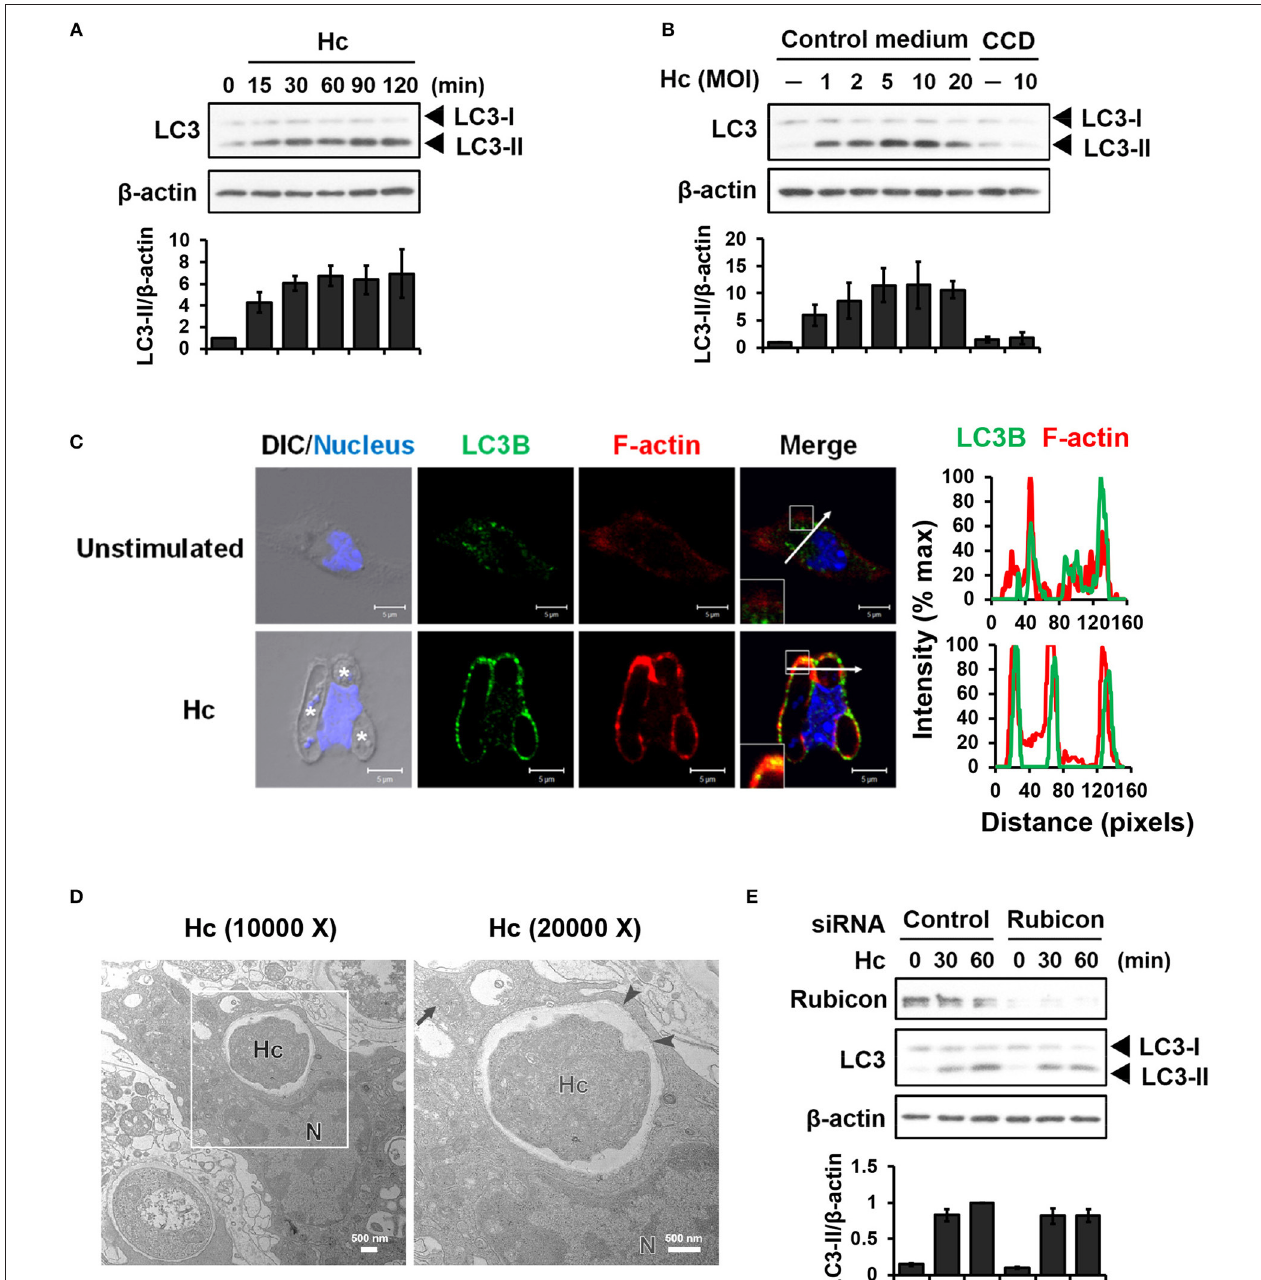
FIGURE 1 | Infection of macrophages with H. capsulatum induces LC3 conversion and recruitment to fungus-containing phagosome. (A) Macrophages from WT mice were stimulated with or without (0min) H. capsulatum (MOI = 5) for the indicated time. Cell lysates were extracted and analyzed by Western blotting. (B) Macrophages from WT mice treated with or without cytochalasin D (CCD, 10 µ g/ml) were stimulated with H. capsulatum at the indicated yeast-to-macrophage ratios for 60min. Cell lysates were extracted and analyzed by Western blotting. (C) Macrophages were stimulated with or without H. capsulatum (MOI = 5) for 60min. Cells were fixed and stained for LC3B (green), F-actin (red), and nucleus compartment (blue). Cells were viewed under confocal microscope. Asterisks in the DIC/Nucleus field point to H. capsulatum yeasts. Box areas are shown at higher magnification in the bottom left corner of the corresponding image. The intensity of different fluorochromes along the white arrow in the merged image is shown as the histogram on the right. Data shown are representative of at least 3 independent experiments with similar results. (D) Macrophages from WT mice were stimulated with or without H. capsulatum (MOI = 2) for 30min. Transmission electron microscopy (TEM) were used to analyze H. capsulatum -containing vacuoles in macrophages. Representative TEM micrographs are shown. Box area in the middle panel is shown as magnified image in the right panel. (E) Macrophages from WT mice were transfected with control siRNA or siRNA against Rubicon (50nM) for 72h. Cells were then stimulated with or without (0min) H. capsulatum (MOI = 5) for 30 and 60min. After stimulation, cell lysates were collected and assessed by Western blotting. Data shown in the lower panel are relative intensity of LC3-II normalized against the corresponding β -actin, mean ± SEM are shown ( n = 3) (A,B,E) .